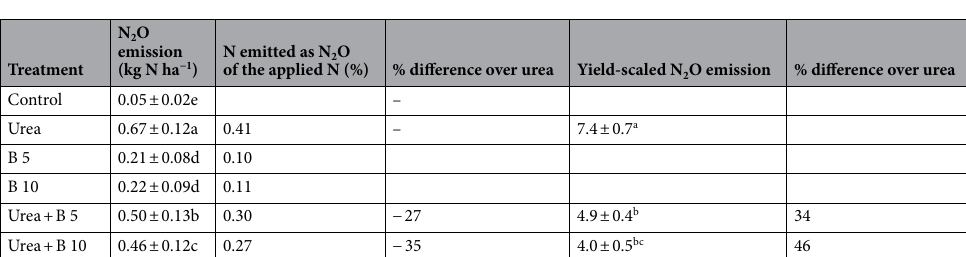
Table 1. Total N 2 O-N release, N emitted as N 2 O, % difference comparative to urea and yield scaled N 2 O emissions in soils amended with sole urea or urea + biochar. Within columns, means followed by the same letter are not significantly different at P <